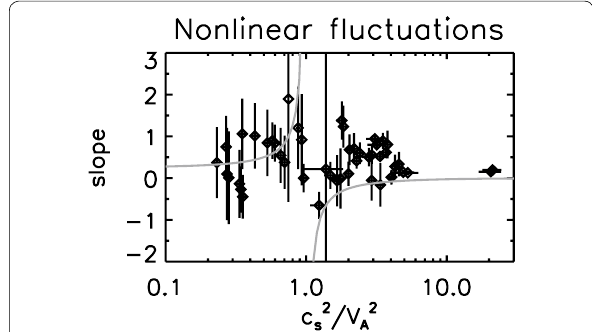
Fig. 4 The same panel as Fig. 3 but the slope is evaluated for the second-order nonlinear magnetic field fluctuation by subtracting by variance of the magnetic field fluctuation, δ B 2 nl lines in gray are the prediction from the quasi-static balance with a slope relation to the beta-tilde ( 2 ( 1